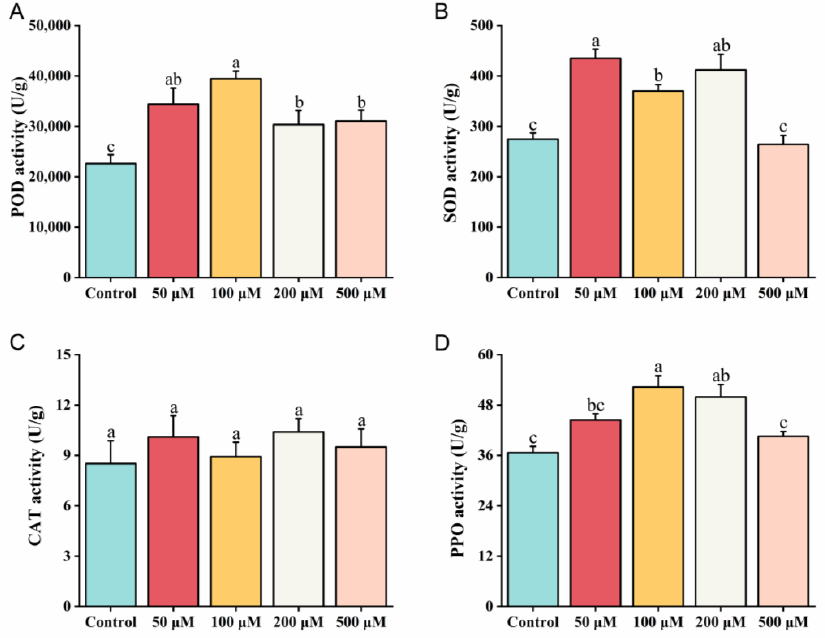
Figure 7. Effects of exogenous serotonin application on activities of defense proteins, including POD ( A ), SOD ( B ), CAT ( C ), and PPO ( D ) 12 h post application in rice. Data are means + SE. Different letters represent significant differences among treatments (one-way ANOVA followed by LSD test).